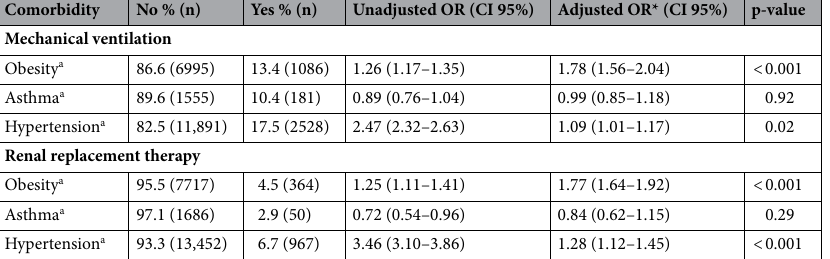
Table 3. Relationship between obesity, asthma, and hypertension with the need for mechanical ventilation and renal replacement therapy in patients with coronavirus 2019 disease from March 1st, 2020 to March 31st, 2021. *Odds ratio adjusted by age group, sex, and other comorbidities through multivariate logistic regression by the enter method. a Values are expressed as relative and absolute